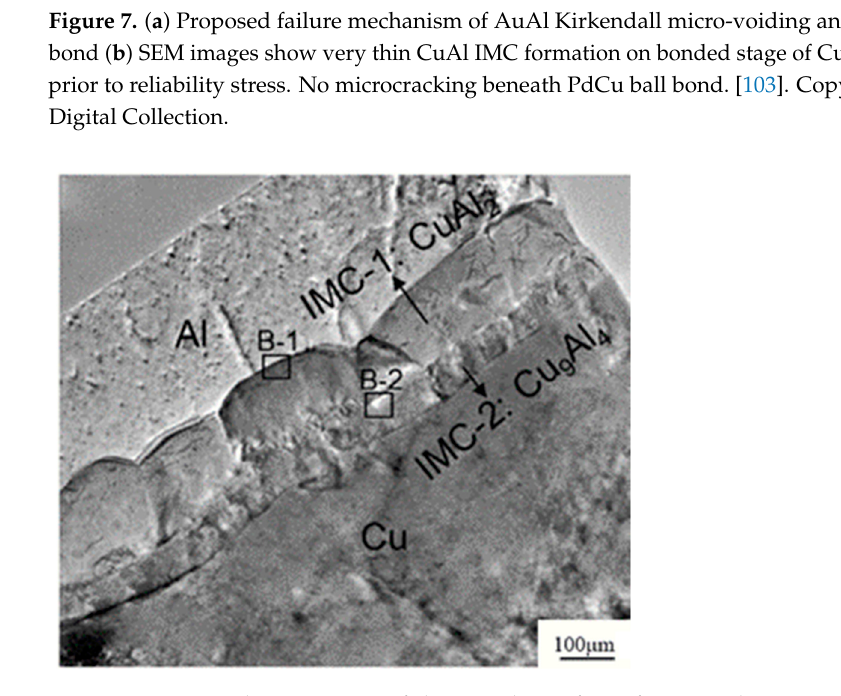
Figure 8. A typical TEM image of the Cu-Al interface after annealing at 175 °C for 25 h [105]. Copyright, 2011, Elsevier.